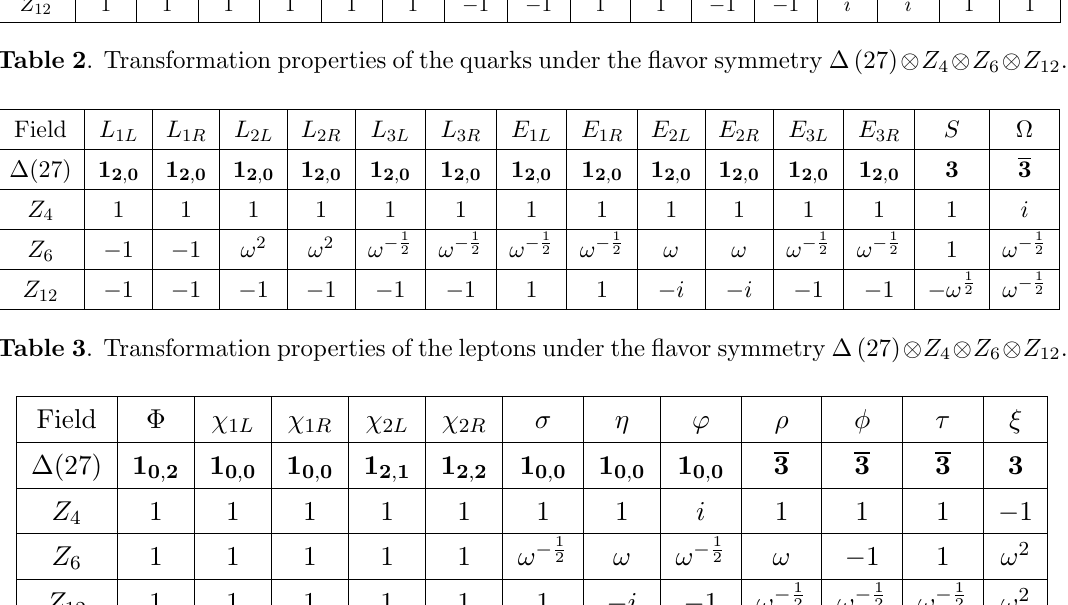
Table 4 . Transformation properties of the scalars under the (cid:13)avor symmetry (cid:1) (27)